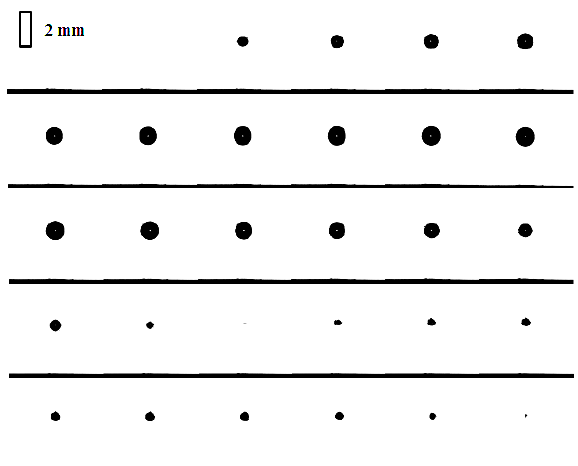
Fig. 3. Bubble dynamics for γ = 4.6. Time between the individual frames is 5.9